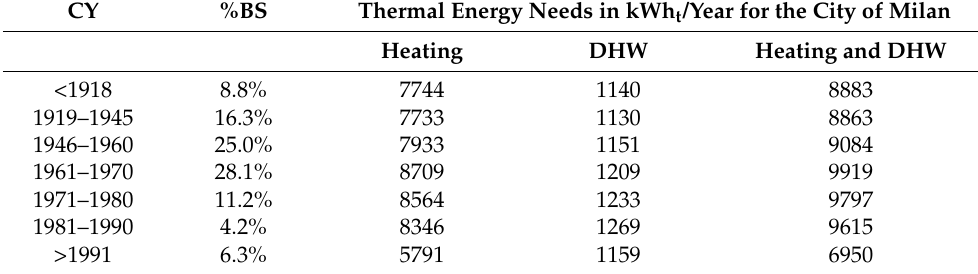
Table 1. Thermal energy needs for space heating and DHW preparation per construction year CY for the city of Milan and portion of the buildings stock